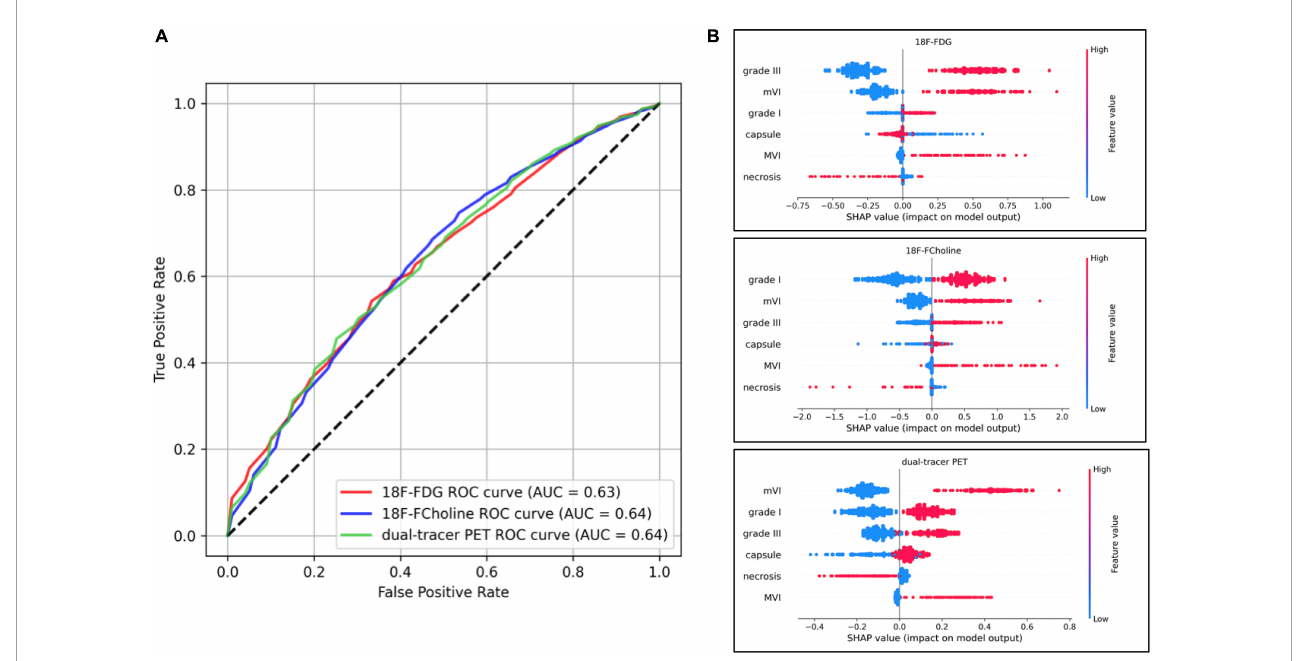
FIGURE5 Model performances including all histological parameters, and Shapley Additive Explanations (SHAP) plot analyses. (A) Receiver operating characteristic (ROC) curves of the three models’ performances. The ROC curve illustrates the capacity of classifiers to discriminate positive and negative cases at different thresholds (e.g., for the 18F-fluorodeoxyglucose (18F-FDG) model and a desired 60% positive rate, the algorithm will yield 40% false alarms). The random model is represented by identity (dotted line) and the perfect model (with no randomness) is y = 1 on [ 0 , 1 ] . (B) Impact on positron emission tomography (PET) positivity is shown with SHAP values on the x-axis, and values of histological characteristics are shown in color (blue and red for low and high values, respectively).